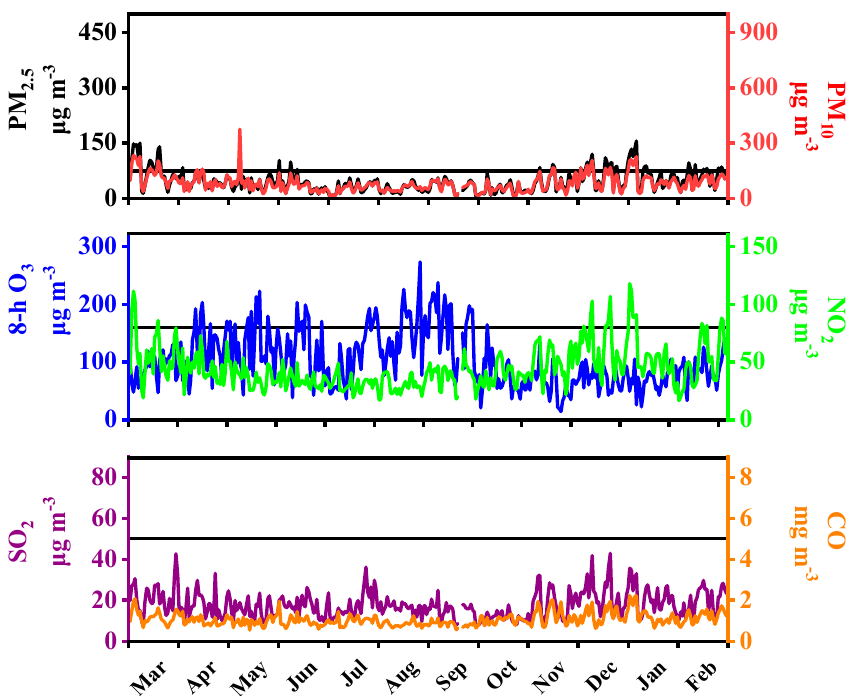
Figure 5. Daily average concentrations of PM 2.5 , PM 10 , CO, NO 2 , SO 2 , and 8-h O 3 in Nanjing in 2016. The horizontal black lines represent the Grade II daily standards of Chinese Ambient Air Quality Standards (CAAQS) for PM 2.5 , PM 10 , NO 2 , and 8-h O 3 , the Grade I daily standards of CAAQS for SO 2 and CO.